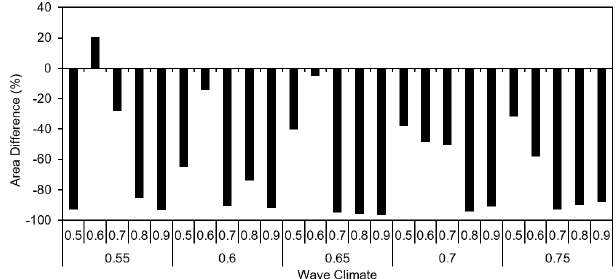
Figure 12. Areal difference (%) between results of CEM2D to CEM. The wave climate given along the x axis is defined according to the wave asymmetry (top row) and the proportion of high-angle waves (bottom